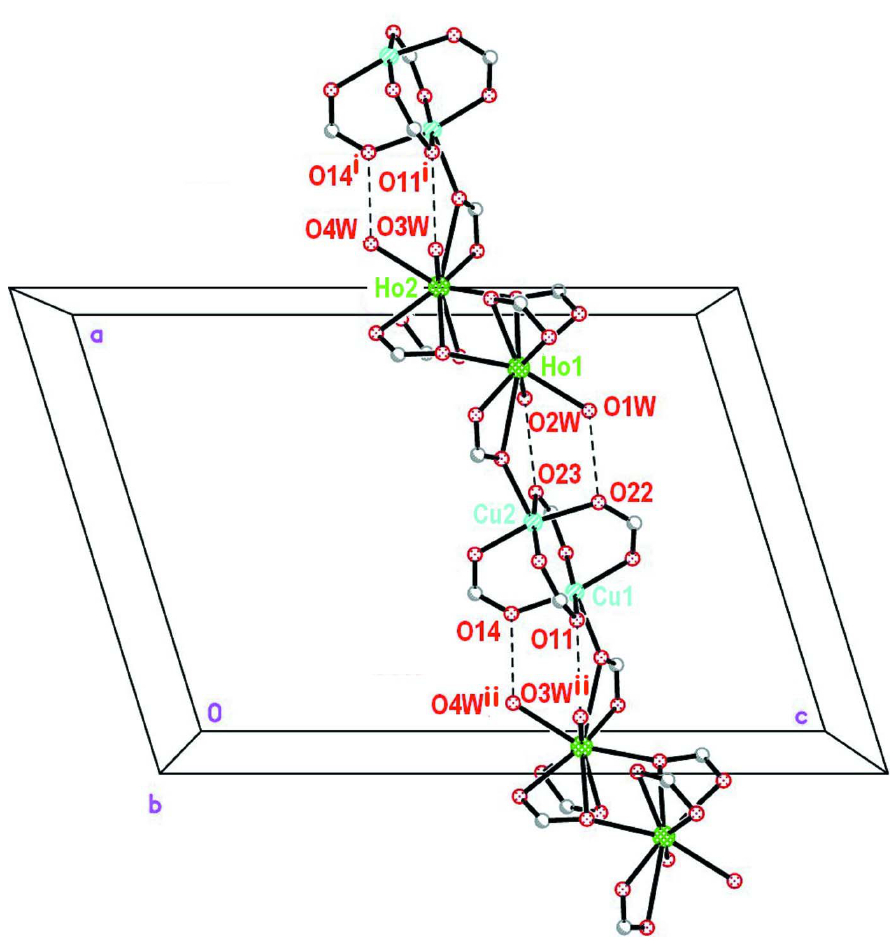
Schematic view of a chain running along [100]. Possible intrachain H-bonds drawn in broken lines. All H atoms and those carbon atoms not in the carboxylate groups, omitted for clarity. Symmetry codes: (i) 1 + x , y , z ; (ii): -1 + x , y , z catena-Poly[[[tetrakis( µ -2-butenoato)dicopper(II)]- µ -2-butenoato- [diaqua(2-butenoato)holmium(III)]-di- µ -2- butenoato- [diaqua(2-butenoato)holmium(III)]- µ -2-butenoato] trihydrate] Crystal